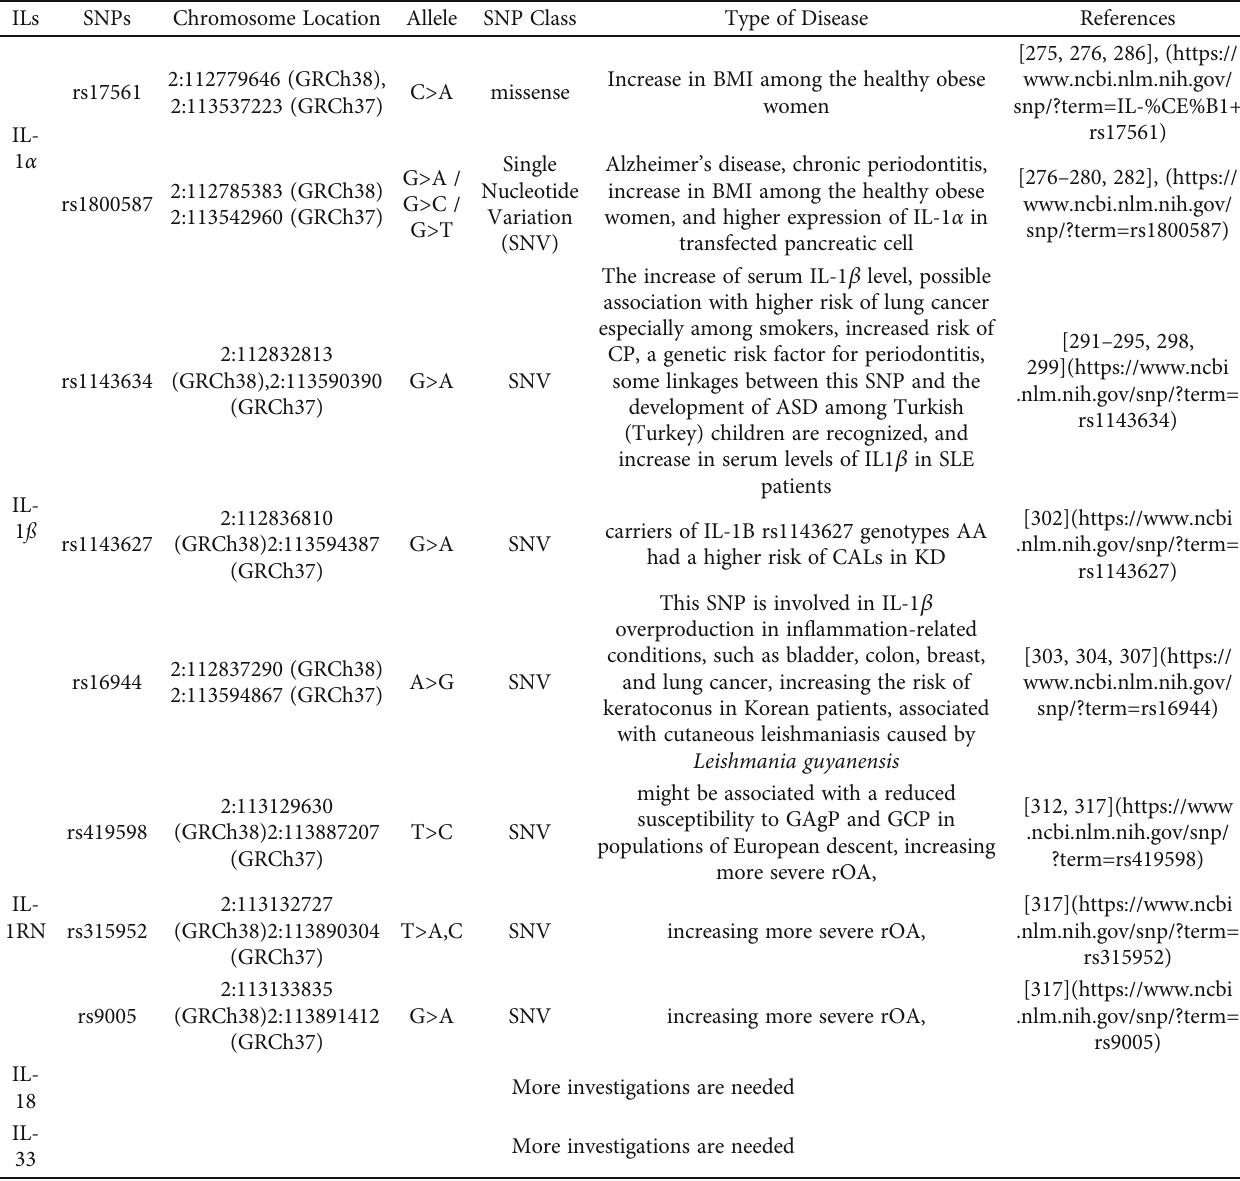
Table 1: The most important SNPs detected in the IL-1 family